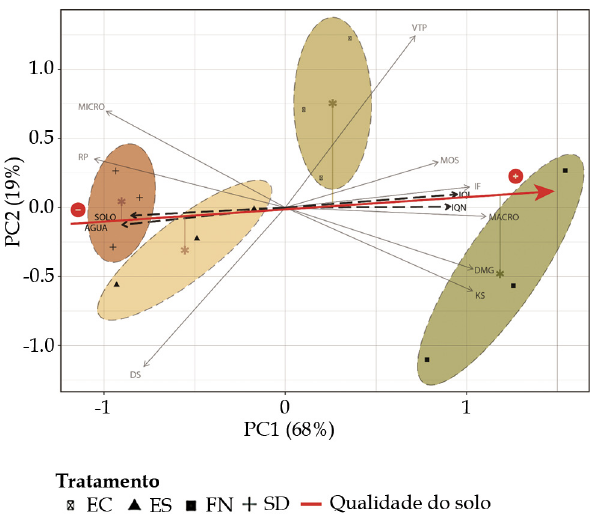
Figura 5. Análise dos componentes principais para os atributos físicos e matéria orgânica do solo (MOS) na classe de solo LVd2. Plantio em nível com resíduo (EC); plantio em nível sem resíduo (ES); plantio em desnível com resíduo (ED); Cerrado nativo (CN); solo descoberto (SD); microporosidade (MICRO); macroporosidade do solo (MACRO); resistência do solo à penetração (RP); densidade do solo (DS); volume total de poros (VTP); índice de floculação (IF); diâmetro médio geométrico de agregados (DMG); permeabilidade do solo a água (KS); perda de solo (SOLO); perda de água (ÁGUA); índice de qualidade integrado (IQI); índice de qualidade Nemoro (IQN); componente principal 1 (PC1); e componente principal 2